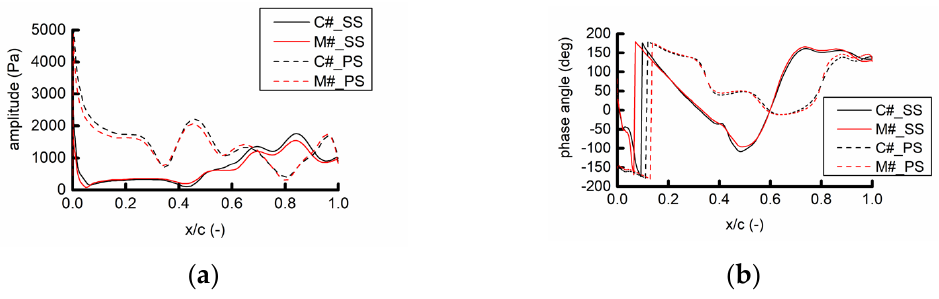
Figure 21. 54 EO component of static pressure at 50% blade span of R1 rotor blade. ( a ) Amplitude ( b ) Phase angle.